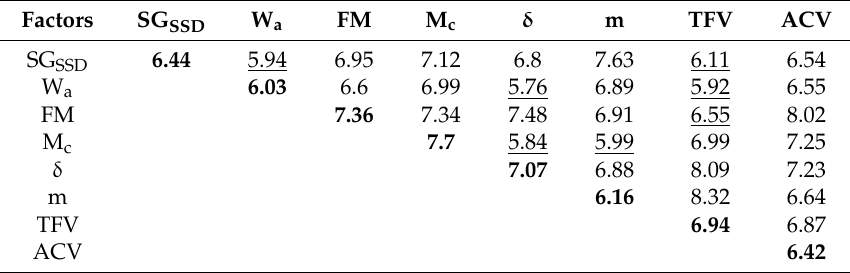
Table 5. The errors of networks for compressive strength with different input variables—Stage b (%).